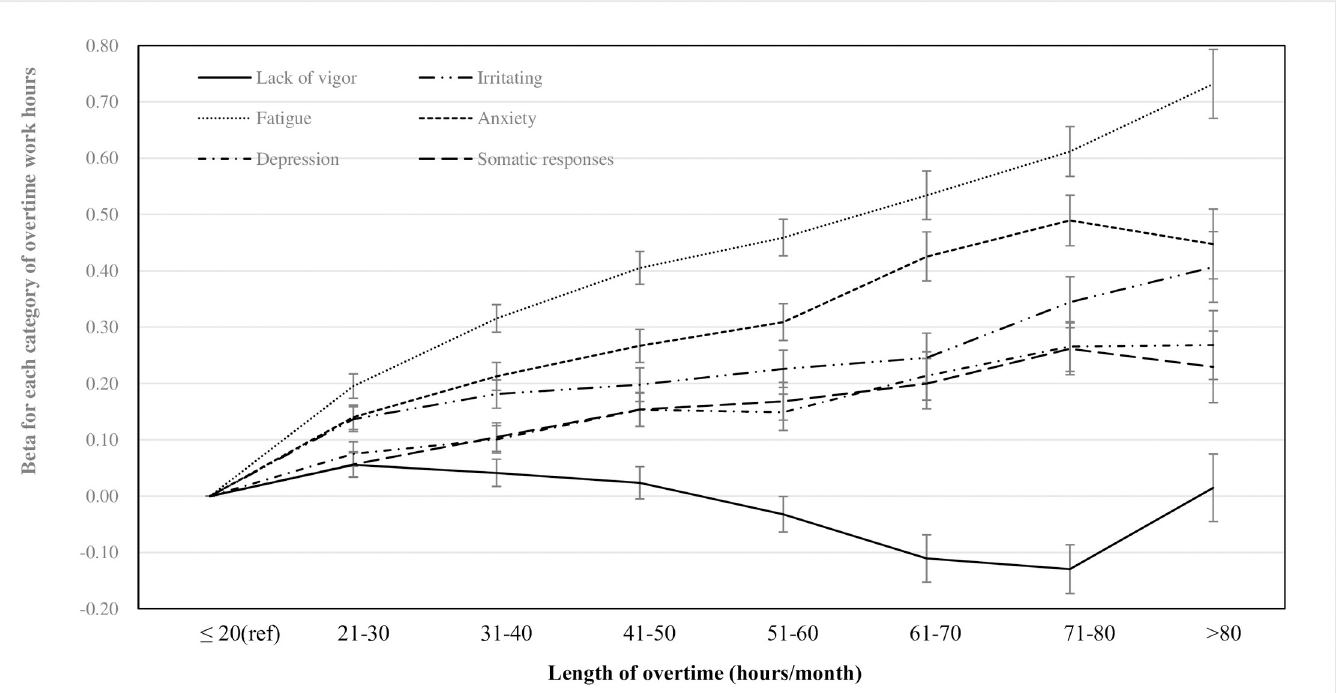
Fig 2. Associations between stress response and overtime work hours; Multiple linear regression results. � Higher score indicates unfavorable stress-response. Adjusted covariates are gender, age, type of job, job class, employment status, type of schedule, company size, company industry, job control, supervisor’s support and coworker’s support. �� Lack of vigor was derived by reversing the score of vigor for harmonization with other stress-response scales, which higher score indicates unfavorable